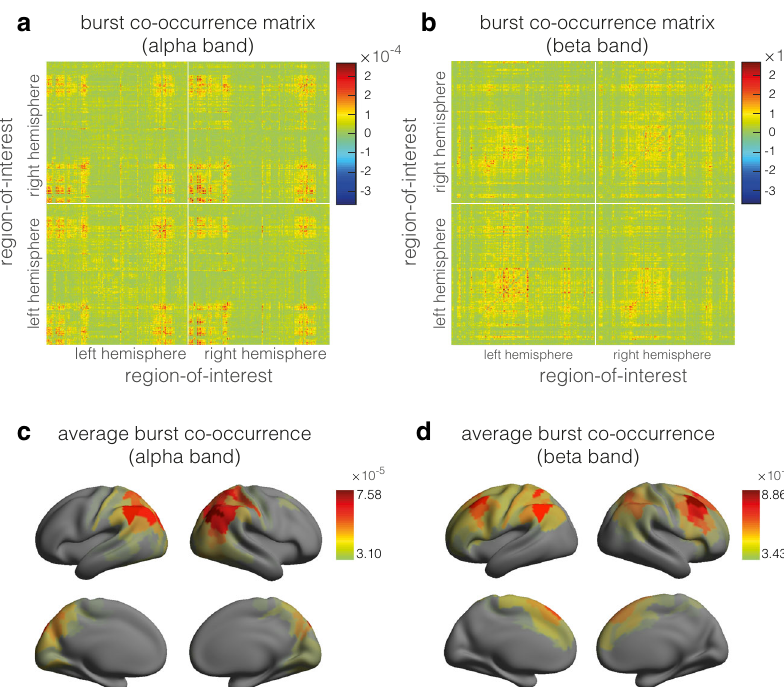
Fig. 6 Burst co-occurrences in resting-state cortical activity. a Burst co-occurrence matrix in the alpha frequency band. b Burst co-occurrence matrix in the beta frequency band. c Colour-coded cortical map of the region-averaged burst co-occurrence in the alpha frequency band. d Colour-coded cortical map of the region-averaged burst co-occurrence in the beta frequency band. The matrices and maps were obtained by averaging over subjects. For better visibility, the cortical maps were thresholded at their average